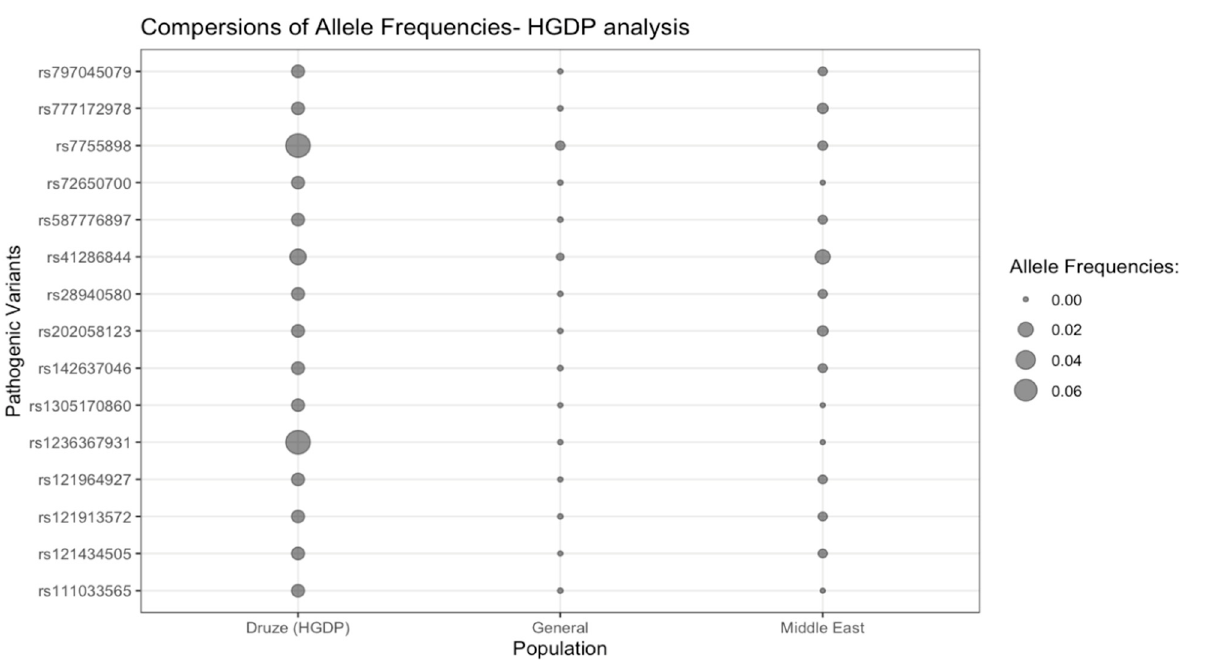
Figure 3. Bubble plot representing the AF of each PV according to the HGDP analysis and with respect to Druze, General, and Middle East populations. Missing allele frequencies are represented by missing bubbles.